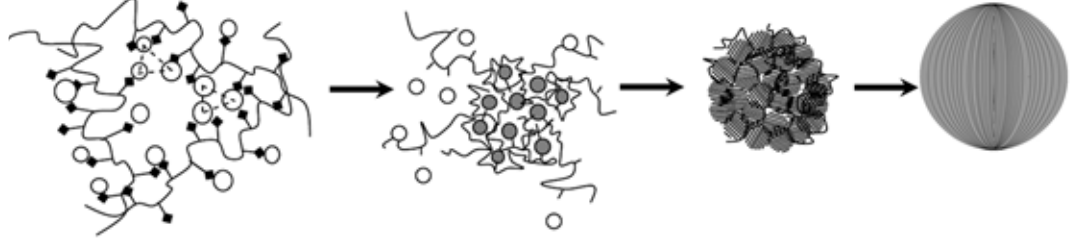
Figure 5. Schematic illustrating the formation of 3D hierarchical structured CeO 2 .